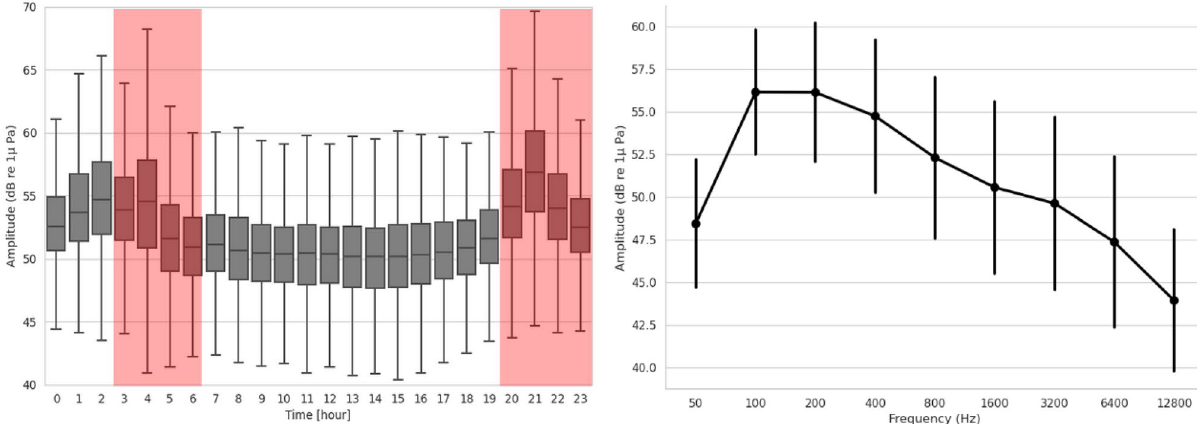
Figure 2. Left: daily pattern of the amplitude for the 800 Hz octave for all records. The red regions represent the ferry period. Right: average of the amplitude for each of the nine octaves, with vertical bars indicating the standard